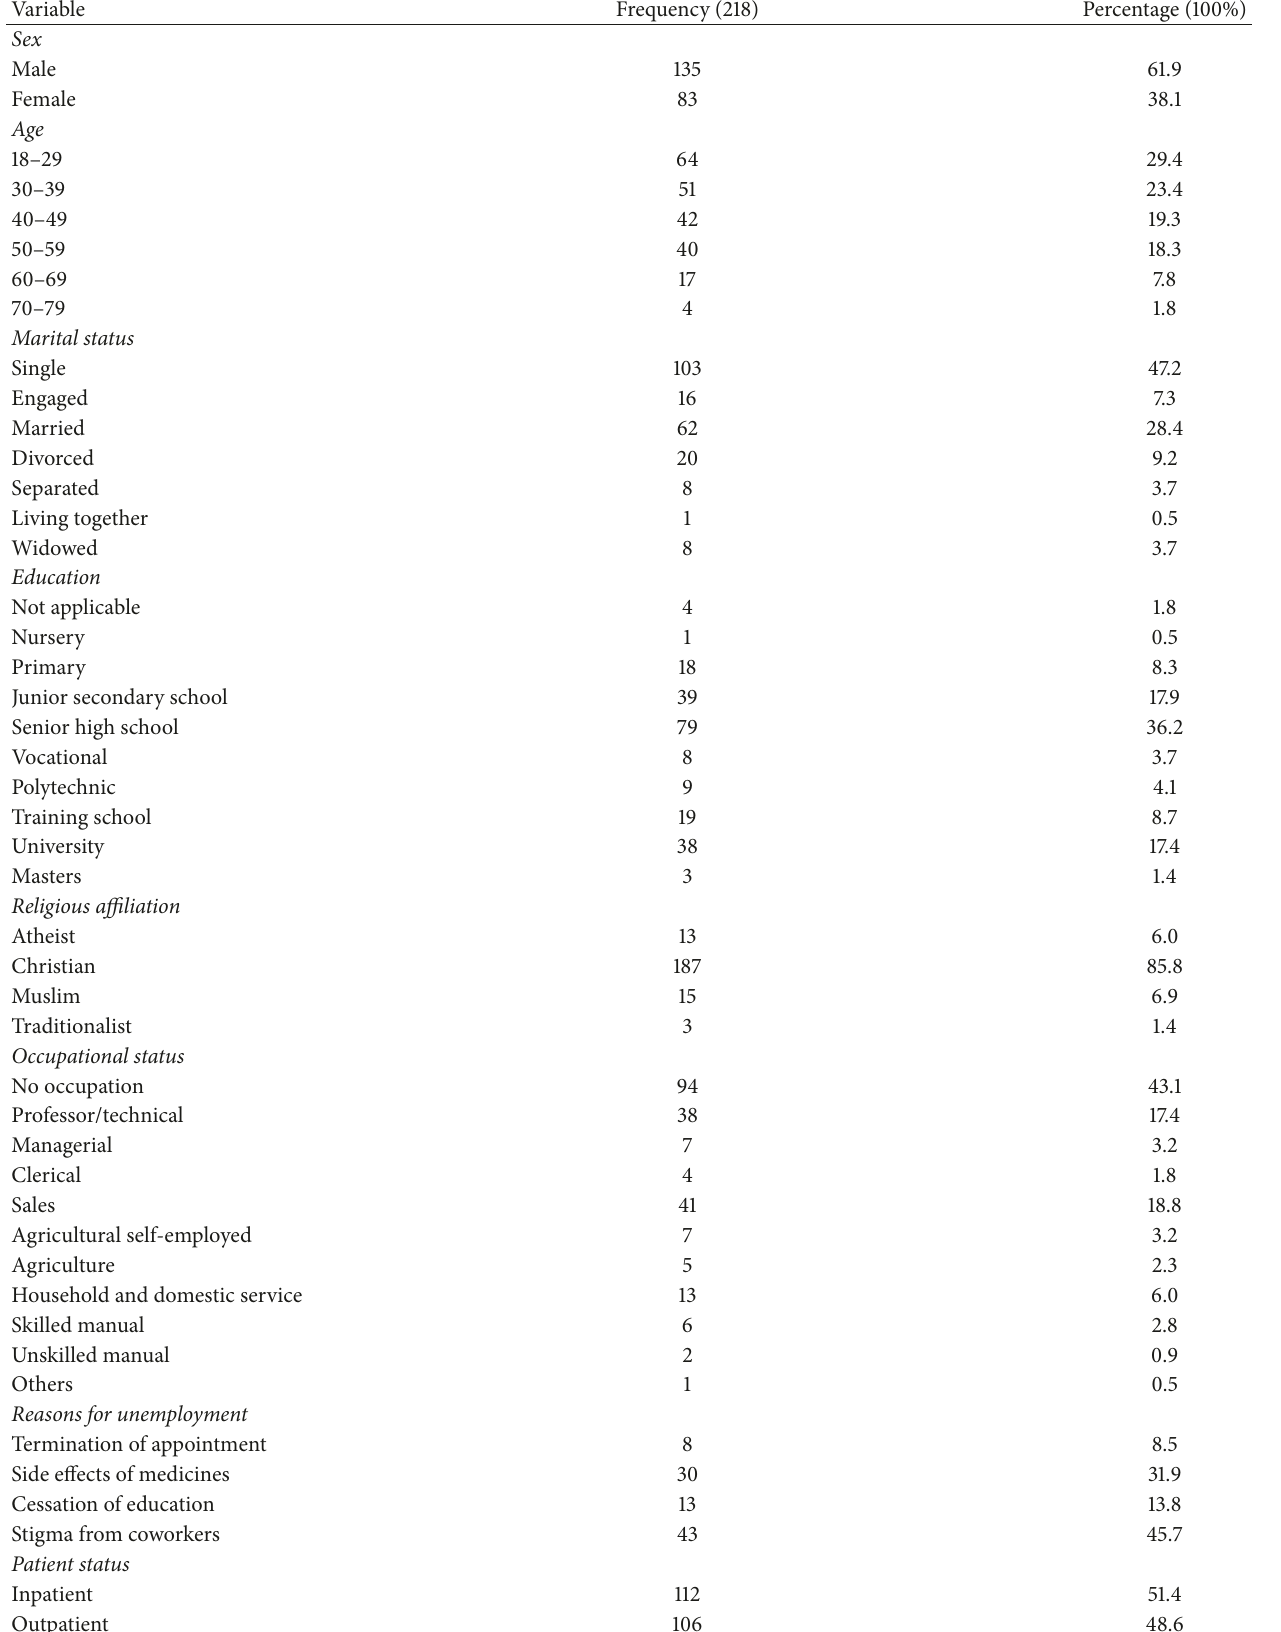
Table 4: Sociodemographic data of study participants who performed above the cut-off for the